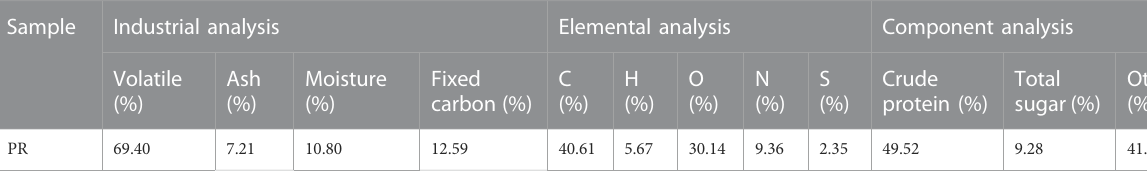
TABLE 1 Characteristic properties of PR.